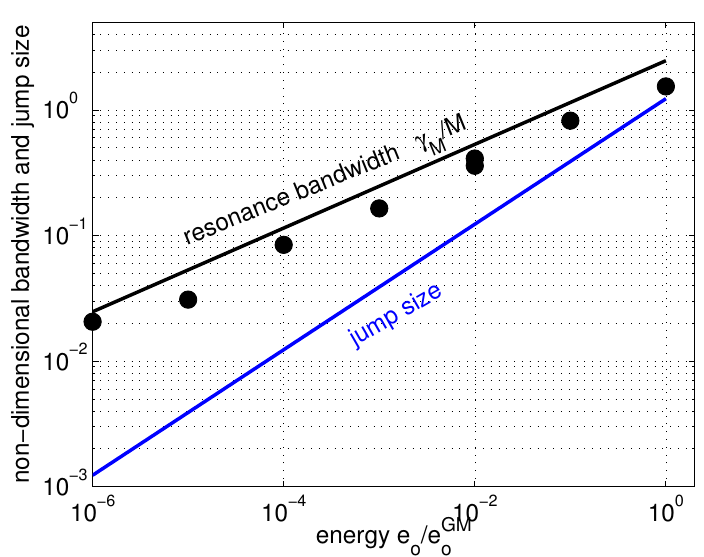
Figure 9. Ray tracing estimates of the half width of the resonant well, black line and symbols; non resonant jump sizes (28), blue line, versus spectral amplitude. Black dots are fits to the phase locking distributions in Section 3.2.2. The resonant bandwidth (27) is rendered as the black line. Jump size and bandwidths have been nondimensionalized by the resonant wavenumber M . The jump size approaches the size of the resonant well at oceanic amplitudes, e o / e GM o = 1, signifying a breakdown of the diffusive